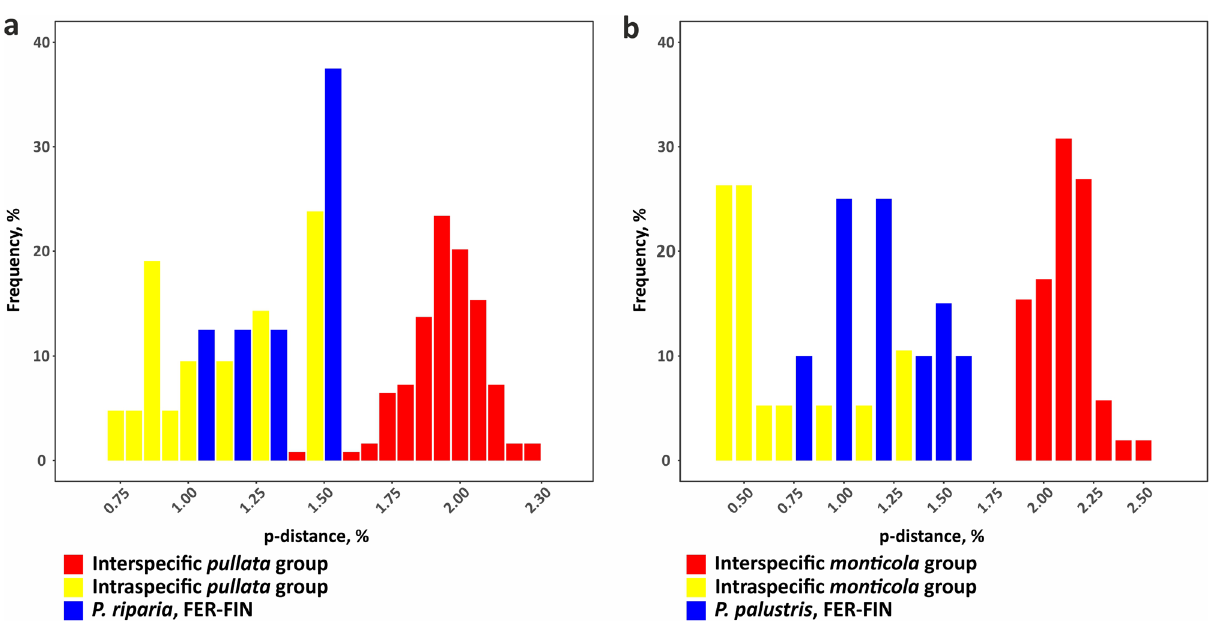
Figure 5. Frequencies of p -distance values observed within species, between species and between distant populations of target species at m = 6. ( a ) pullata group and P. riparia specimens, Rip_m6c85 dataset; ( b ) monticola group and P. palustris specimens, Pal_mon_m6c85